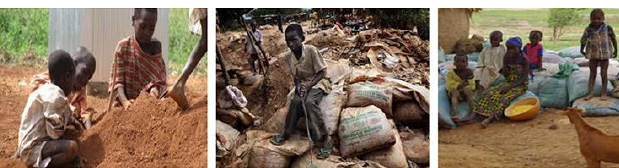
Figure 2: Processing of the precious ores (Source: earthmagazine.org; globalhomesmagazine.com)